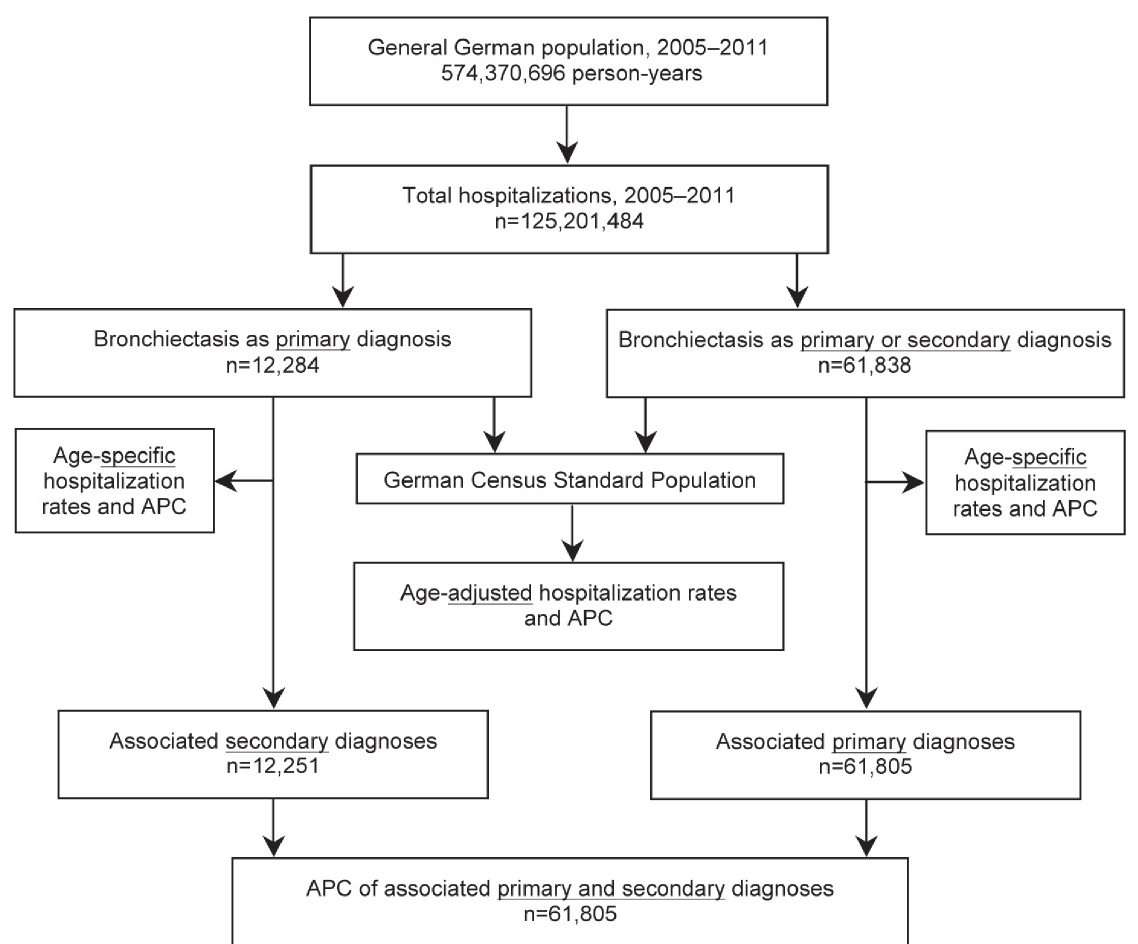
Figure 1. Data flow diagram. APC: annual percentage change.